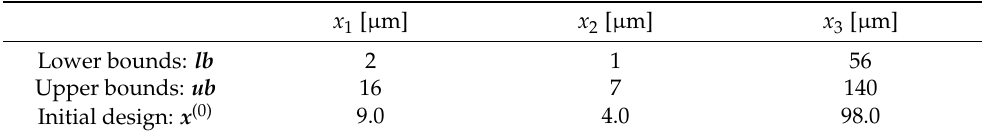
Table 5. Problem setup for design example no. 2: lb , ub , and x (0) . x 1 [ µ m] x 2 [ µ